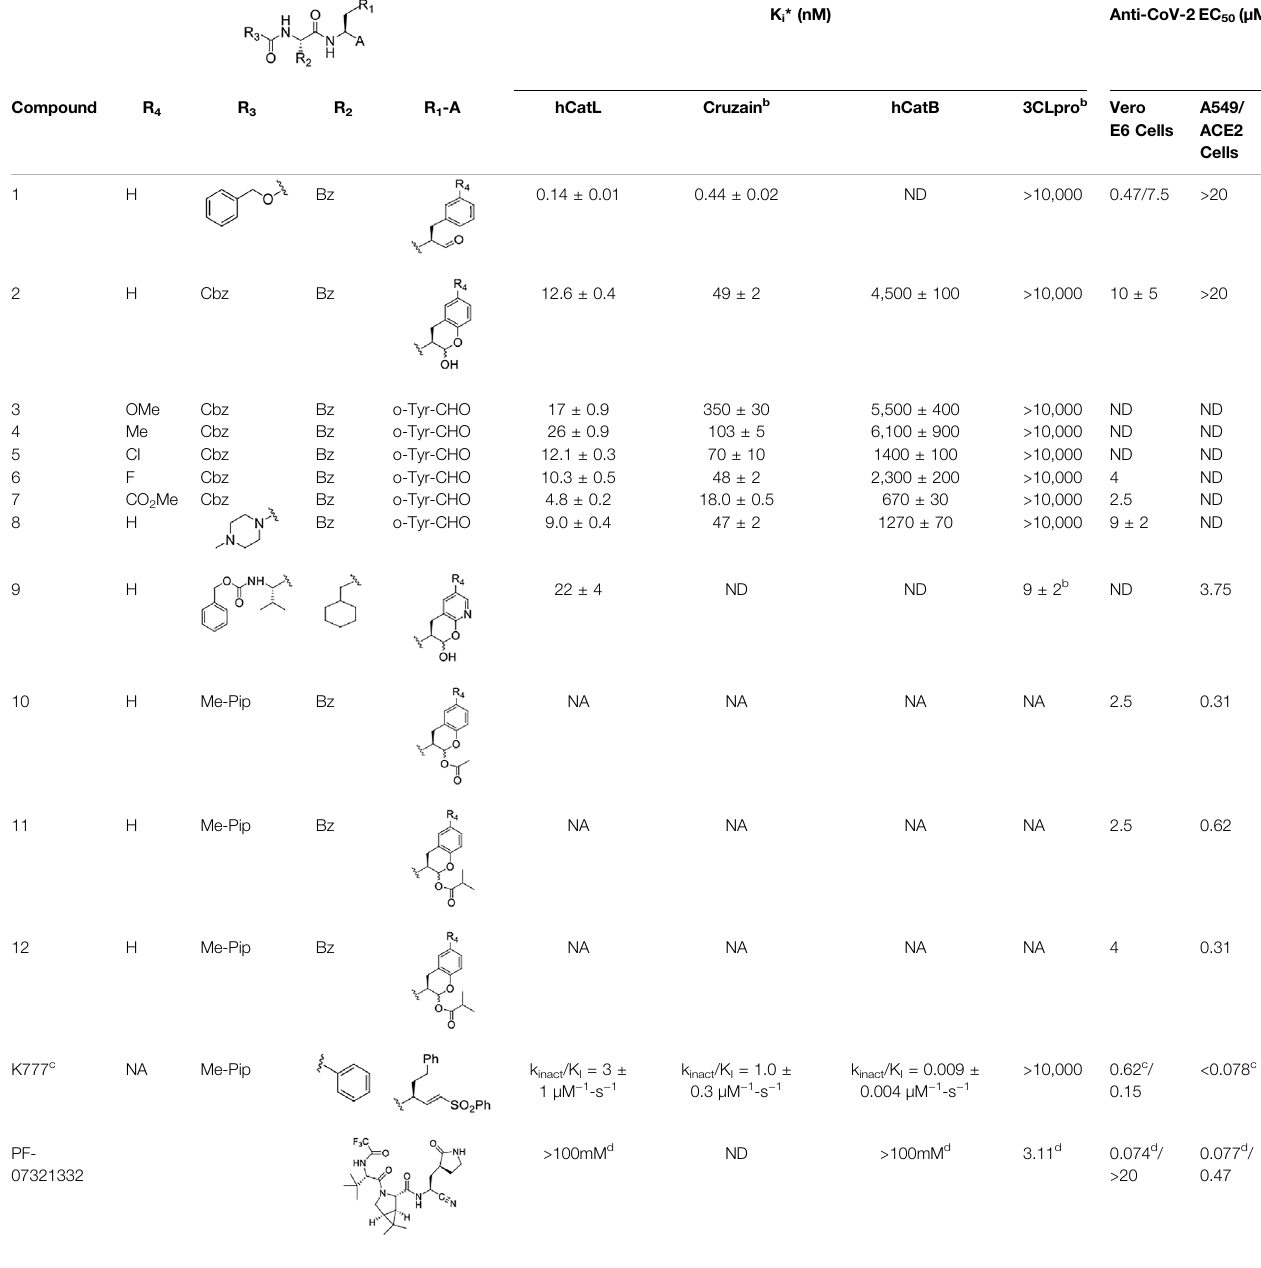
TABLE 1 | Self-masked aldehyde inhibitors of cysteine proteases and their effects on SARS-CoV-2 infected cells a .